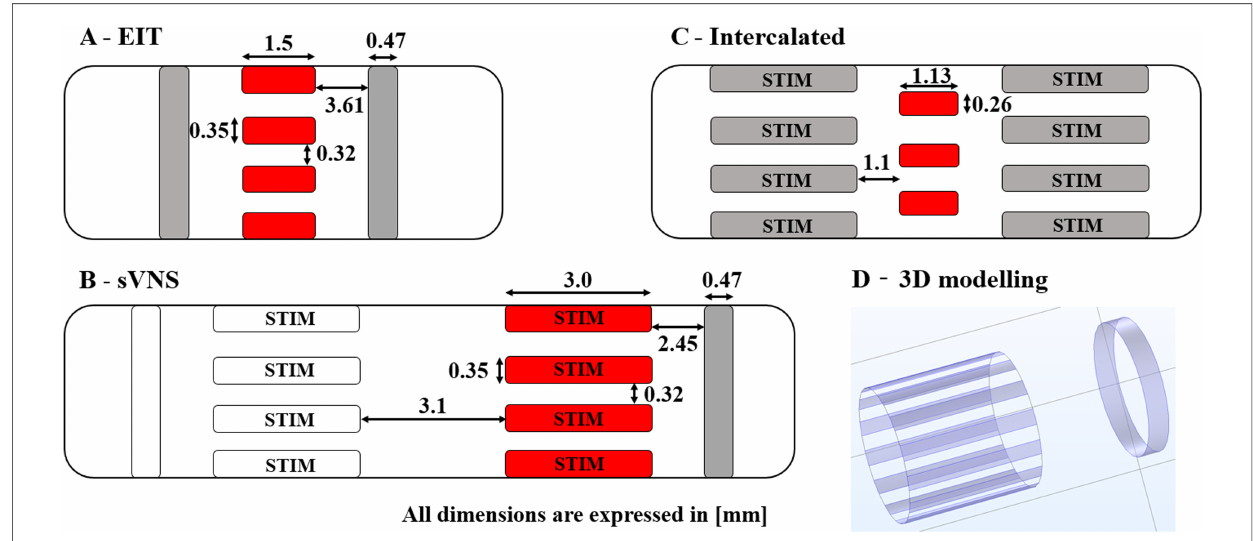
FIGURE 1 Diagrams of 3D electrode geometries tested in simulation with dimensions. ( A ) Original EIT array. ( B ) Original sVNS array. ( C ) Intercalated array. ( D ) Example of 3D electrode positions for the the sVNS design. Red pads indicate electrodes used for EIT current injection; grey pads electrodes are used as EIT voltage measurement reference. Electrode which are also used for selective stimulation are marked as “ STIM ”